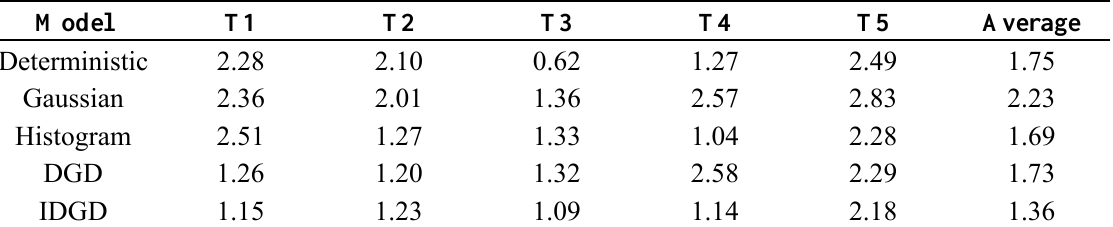
Table 2. Positioning errors of test 1 (unit: metres).